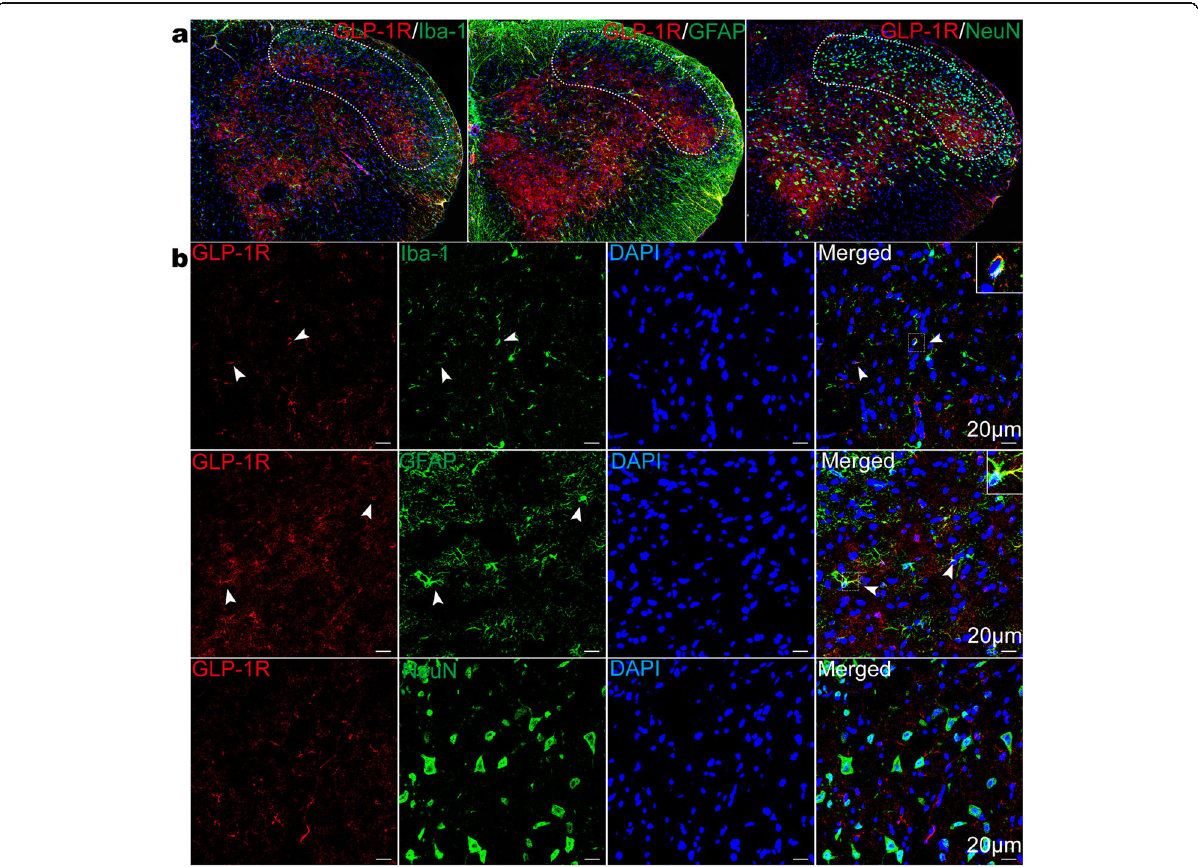
Fig. 2 GLP-1R immunoreactivity localized to microglia and astrocytes in the TNC. a, b Double immunofluorescence labelling of GLP-1R (red) with Iba1, GFAP and NeuN (green) in the TNC in CM mice after NTG injection. The graphs in a show the TNC regions, which are marked by the white dotted line frame. The graphs in b show higher magnification images. Arrowheads show double-labelled cells. Scale bar: 20 μ